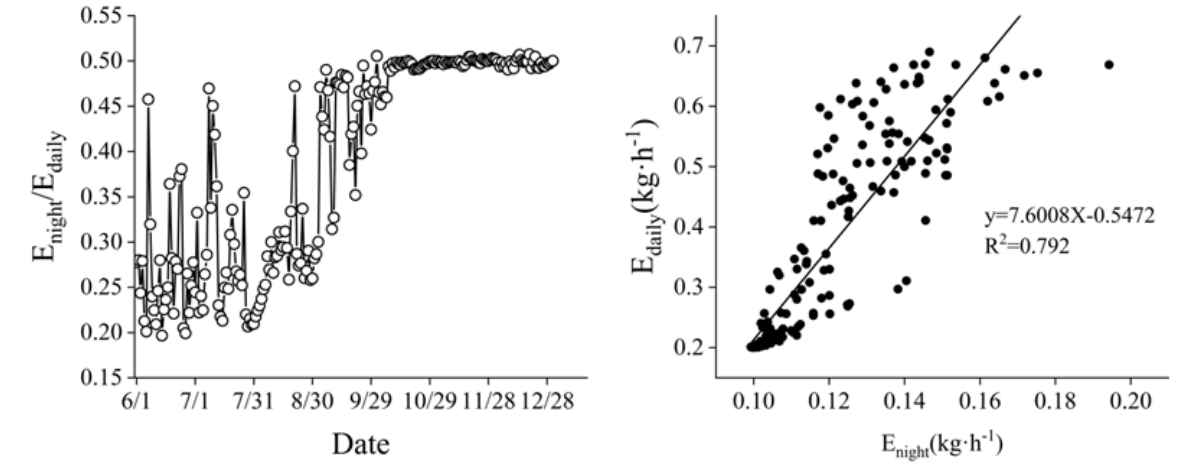
Figure 11. Seasonal variation and linear regression of daytime and nighttime sap flow ratios .